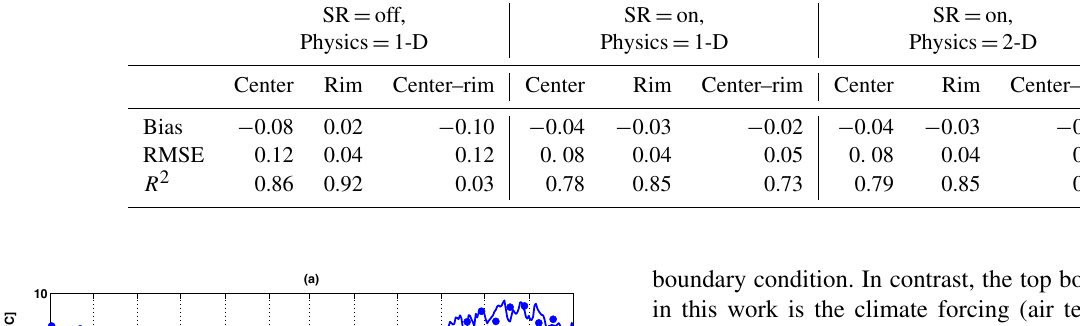
Table 1. Bias, root mean square error (RMSE), and correlation ( R 2 ) between modeled and observed snow depth at polygon center and rim, and the difference between center and rim for 2013 for three cases: snow redistribution (SR) off and 1-D physics, SR on and 1-D physics, and SR on and 2-D physics. SR = off, SR = on,